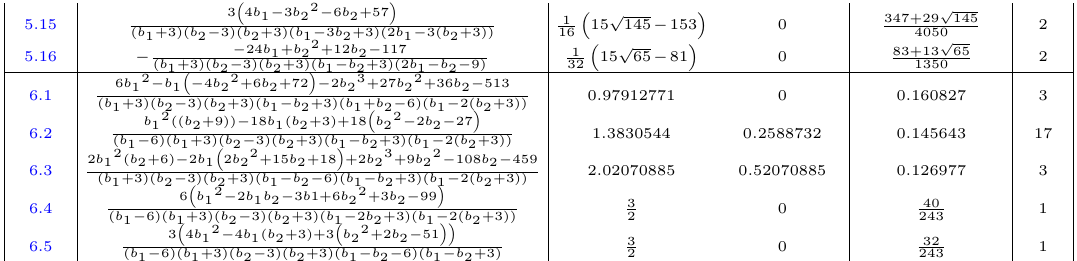
Table 3. Volume functions V , critical Reeb vectors b (cid:3) V min , with b 3 = 3. In the last column, we list the degree of the extension L (of Q ), where L =